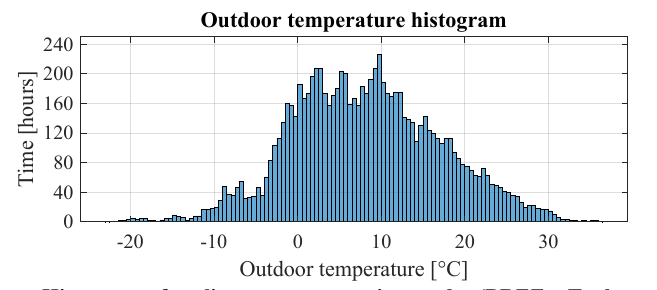
Figure 4. Outdoor temperature 2017.